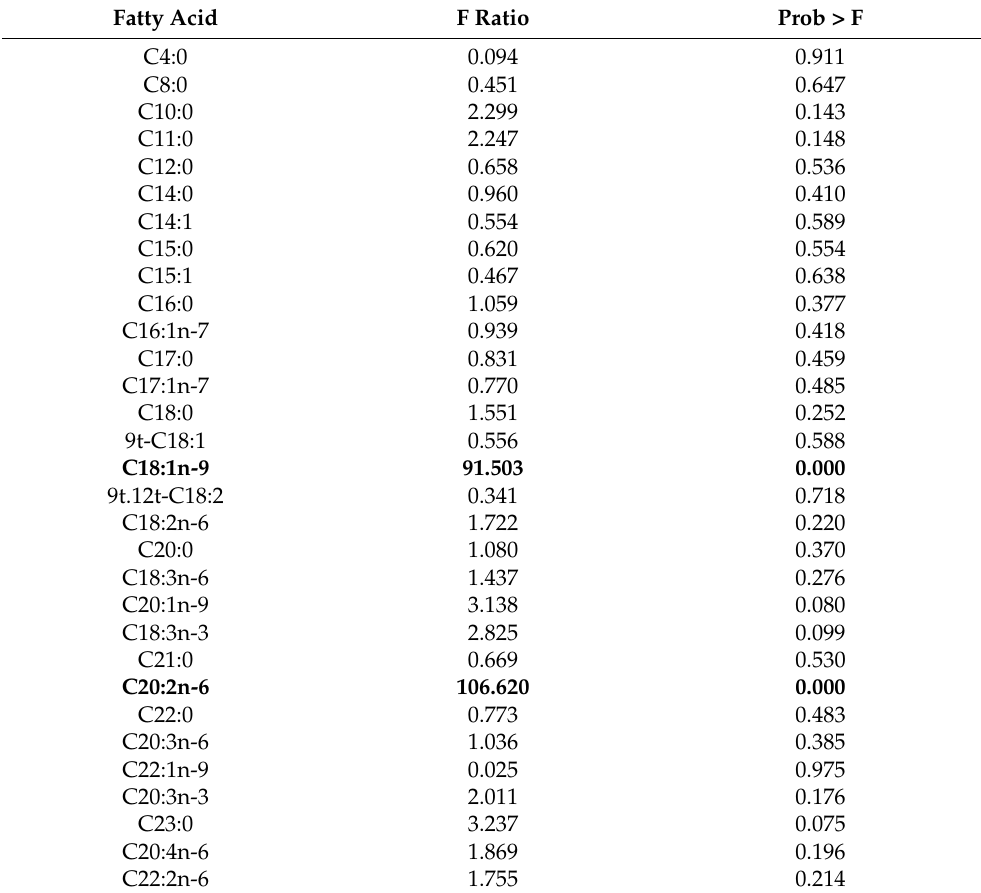
Table 6. Values Prob > F from discriminant analysis of goat meat burgers with fat replacement. Fatty Acid F Ratio Prob >